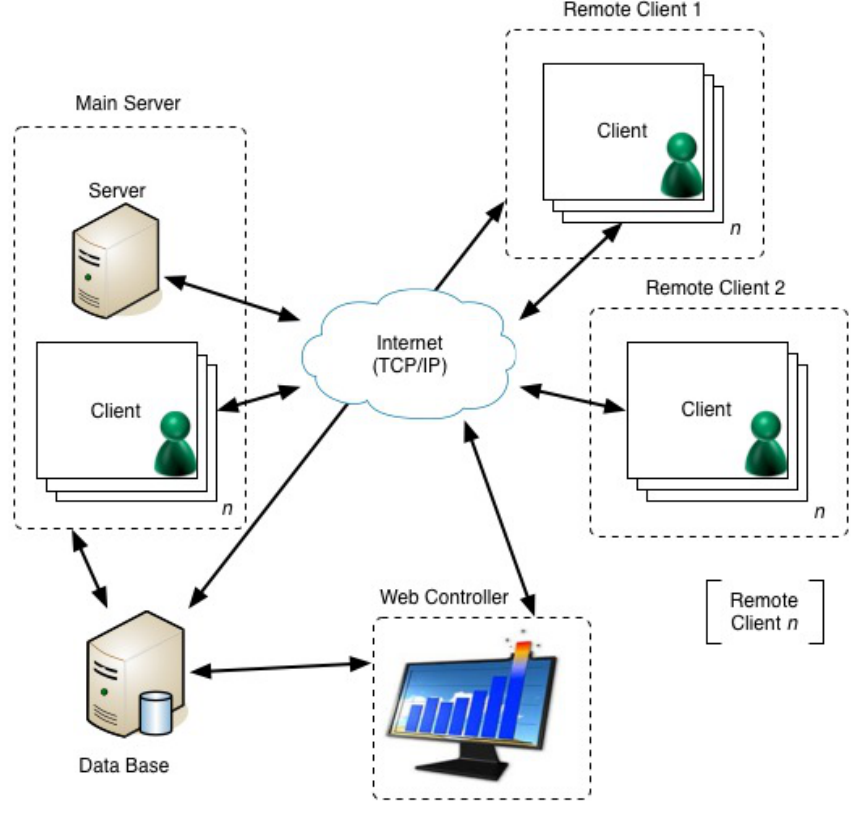
Figure 3. Architecture of the module for controlling the agent community of the Agency for Integration, Diffusion and Archive of Medical Information